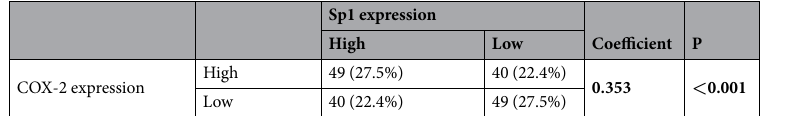
Table 1. Sp1 was positively correlated with COX-2 in PDAC